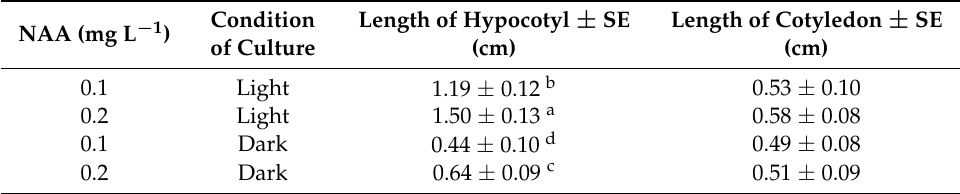
Table 4. Effects of NAA and culture condition on cotyledon embryo growth in K. paniculata